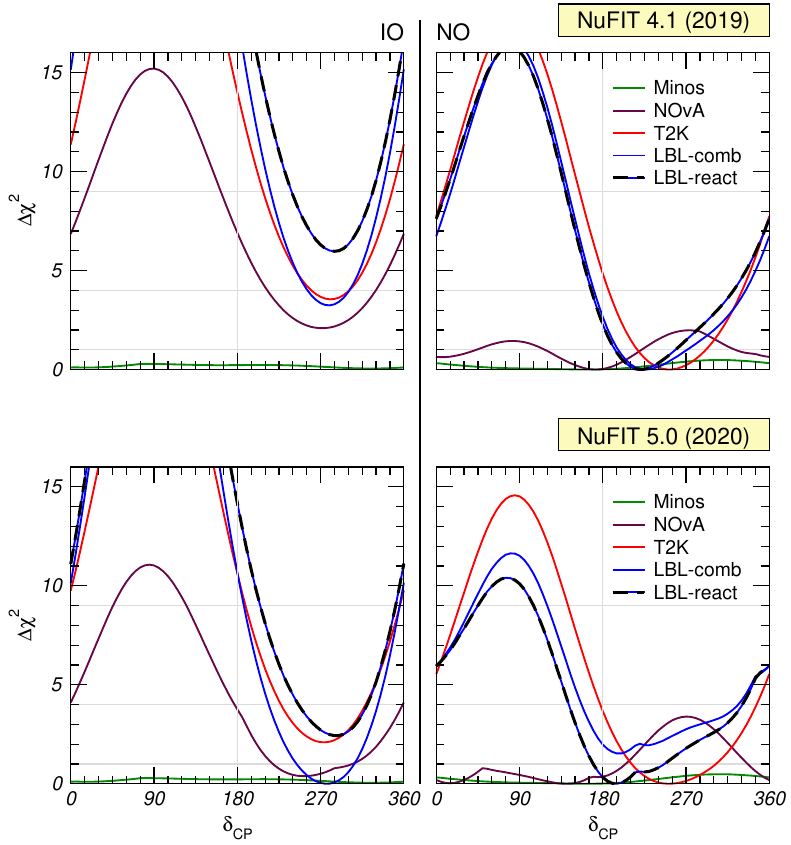
Figure 2 . (cid:1) (cid:31) 2 pro(cid:12)les as a function of (cid:14) CP for di(cid:11)erent LBL data sets and their combination. We have (cid:12)xed sin 2 (cid:18) 13 = 0 : 0224 as well as the solar parameters and minimized with respect to (cid:18) 23 and j (cid:1) m 2 j . The black/blue dashed curves correspond to the combination of LBL data with the 3 ‘ reactor experiments Day-aBay, RENO, Double-Chooz, and in this case also (cid:18) 13 is left free in the (cid:12)t. Left (right) panels are for IO (NO) and (cid:1) (cid:31) 2 is shown with respect to the global best (cid:12)t point for each curve. Upper panels are for the NuFIT 4.1 data set, whereas lower panels correspond to the current